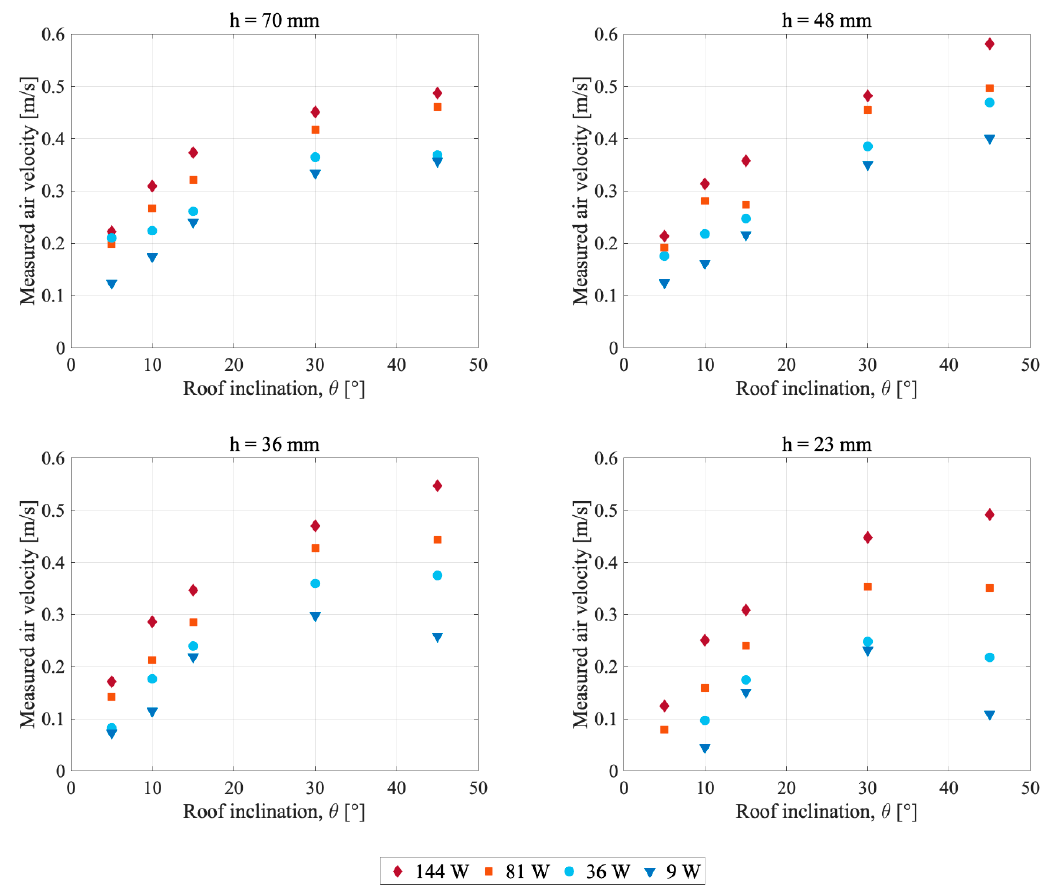
Figure 7. Measured air velocities at different roof inclinations, air cavity heights and applied heating power. Note that measured air velocity is the assumed maximum velocity through the air cavity.